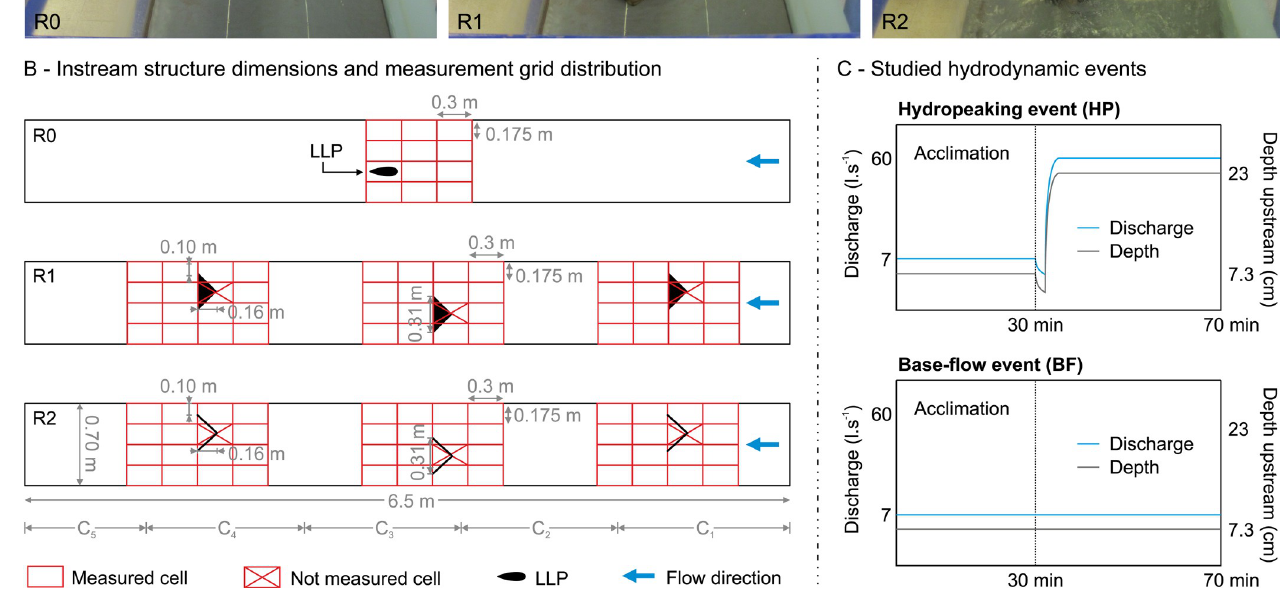
Fig 1. Summary of the experimental setup. A) Top view of the flume and test configurations (R0, R1 and R2). B) Plan of the setup with dimensions, grid of hydrodynamic measurements, and observation zones (C1 to C5). C) Depth and discharge of the studied hydrodynamic events.